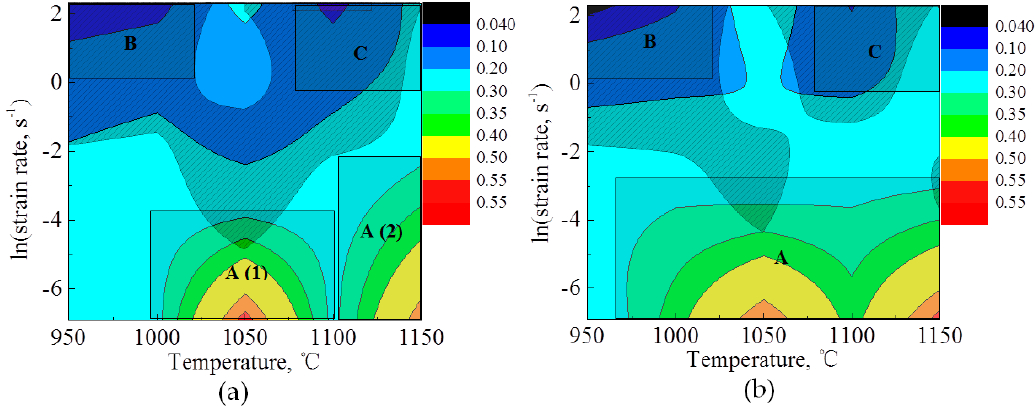
Figure 8. Hot processing map of 316LN stainless steel at: ( a ) ε = 0.4; ( b ) ε = 0.9 (The legend scale represents the power dissipation efficiency).